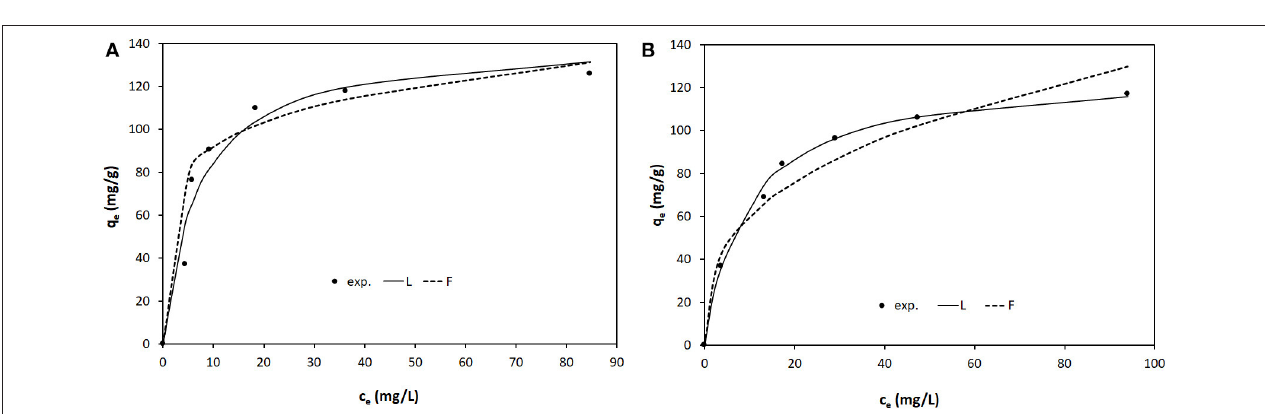
FIGURE 8 | Equilibrium isotherms of Orange II adsorption onto: (A) LDH-R and (B) LDH-W at